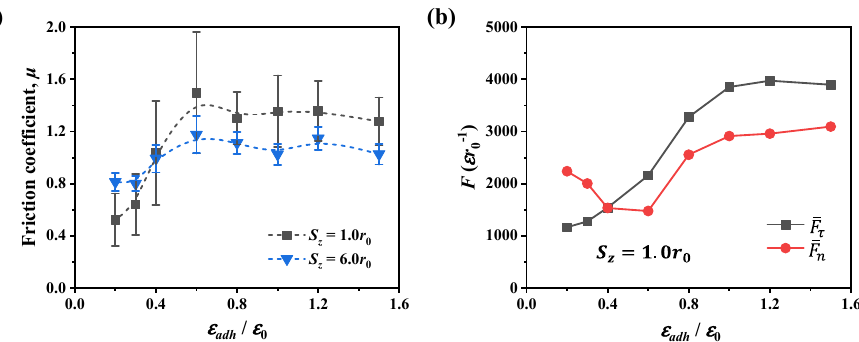
Figure 3. ( a ) Friction coefficient at two scratch depths as the interfacial adhesion changes, and the dashed lines are guides for eyes. ( b ) Averaged tangential and normal forces between tip and substrate at a depth of 1.0 r 0 . Scratch test is performed in material of r c = 1.22 r 0 .